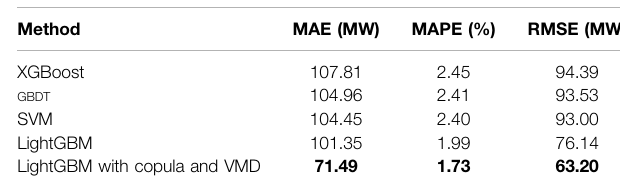
TABLE 2 | comparison of evaluation results with three